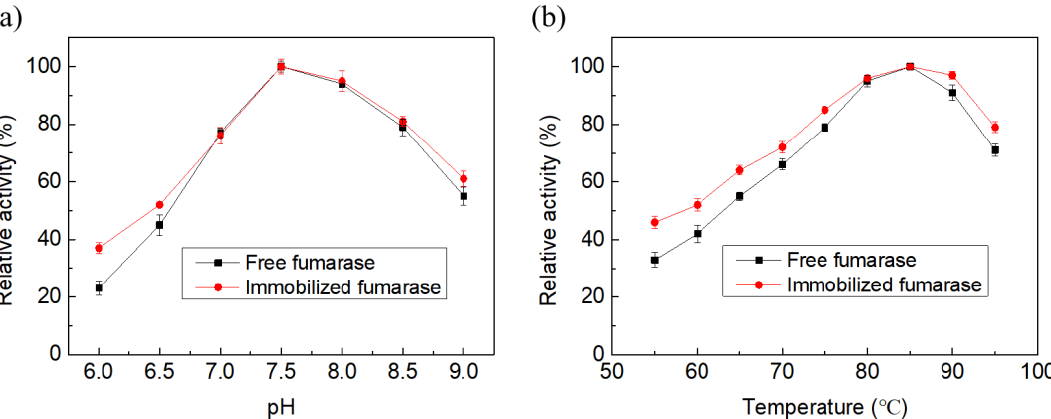
Figure 2. The relative initial activity of immobilized and free fumarase at different pH ( a ) and temperature ( b ) conditions.